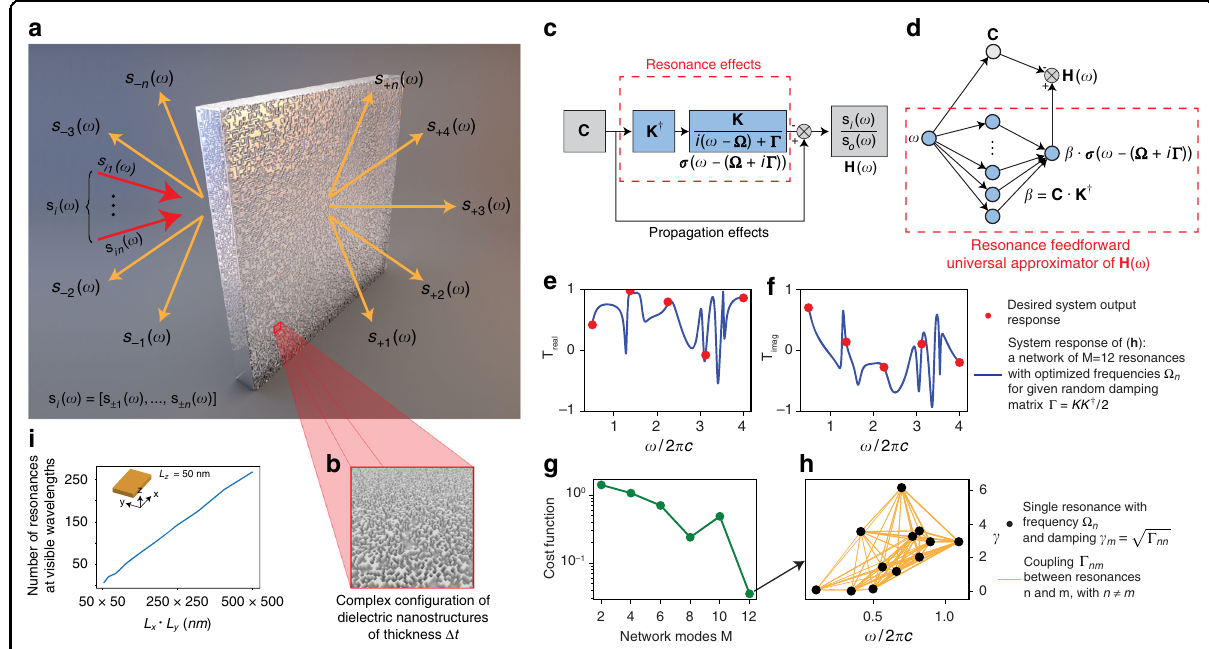
Fig. 1 Universal fl at-optics approximators: general idea. a Problem setup composed of a fl at optical surface constituted by resonant nanostructures: b with input s i and output s o scattered waves. ( i ) Dependency of the number of resonances on the dimensions of a nanostructure. . d Equivalent representation of ( c ) with a feedforward single hidden layer neural c Block diagram of the input – output transfer function H ω ð Þ ¼ s o ω ð Þ s i ω ð Þ network modelling the effects of the resonances. e – h Demonstration of the universal representation behaviour of ( d ): an arbitrarily de fi ned system response ( e , f , red markers) is obtained by tuning the resonances Ω of the network for given initial weights β , couplings Κ and damping Γ . The problem is solved by minimizing a cost function ( g ) by using an increasing number of resonances M , which de fi nes the size of Ω . h Network con fi guration that represents the desired response ( e , f , solid lines). The general demonstration of this result for an arbitrary structure is carried out